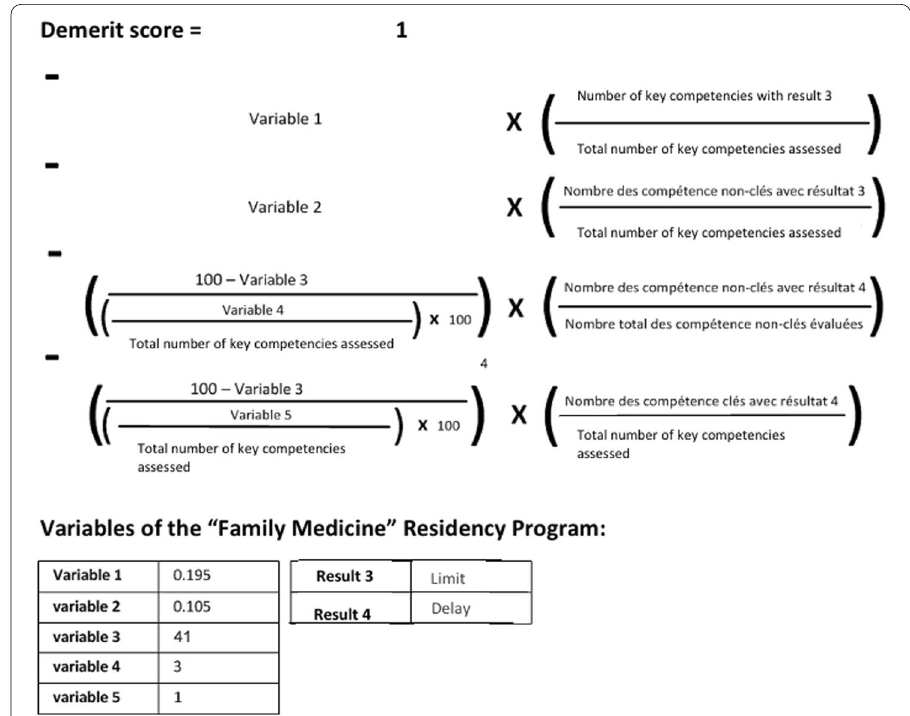
Fig. 6 Proposed mathematical formula for calculating the final